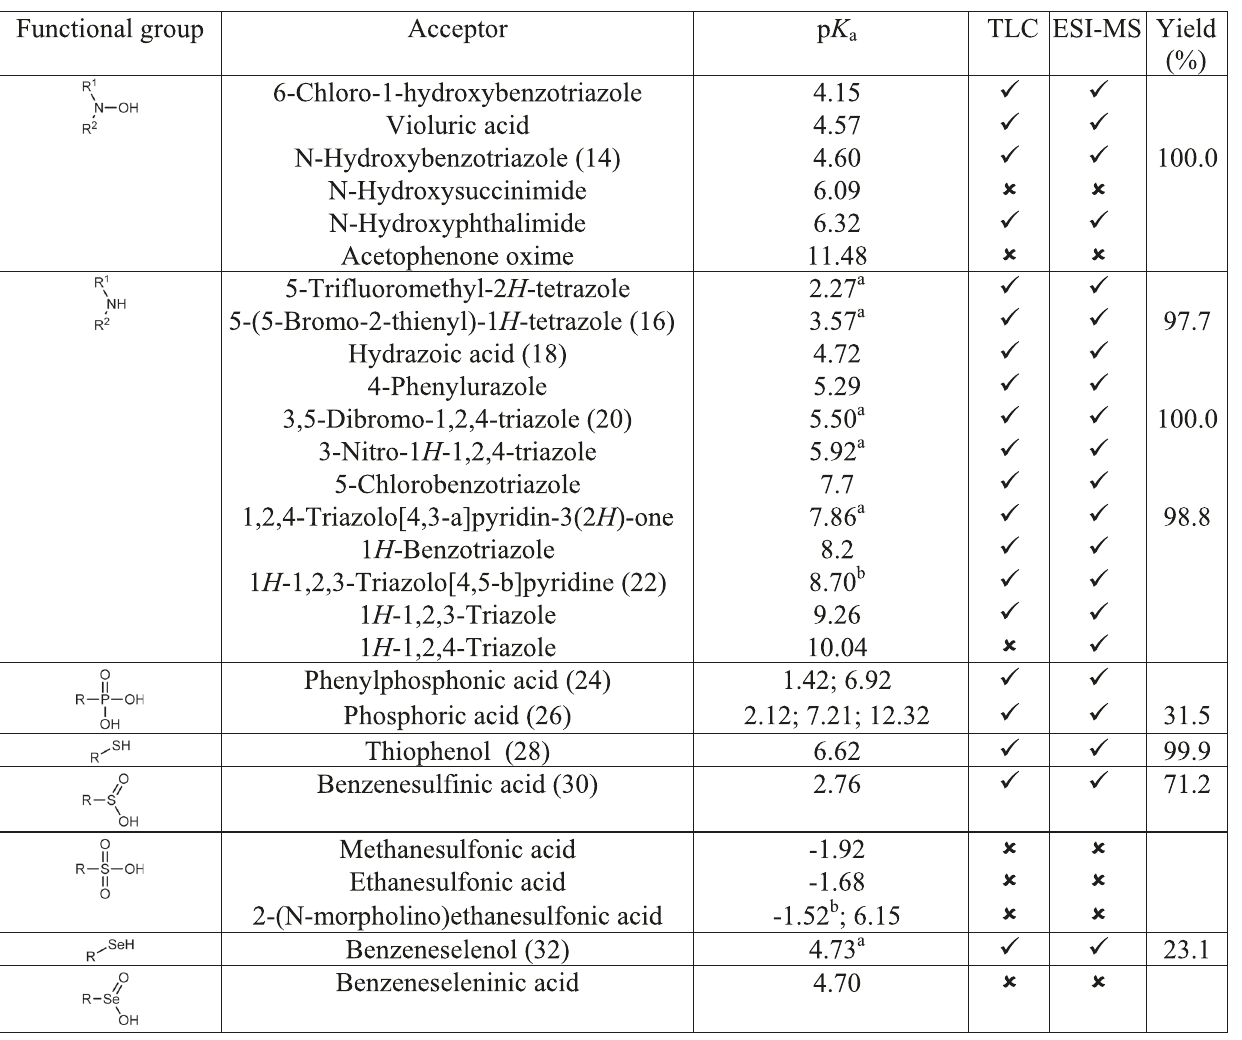
✗ : No product detected, ✓ : Product detected. Bold numbers are referred to Fig. 2 and indicate that the products from those acceptors were additionally identi fi ed by NMR. a Predicted values from SciFinder. b Predicted values from